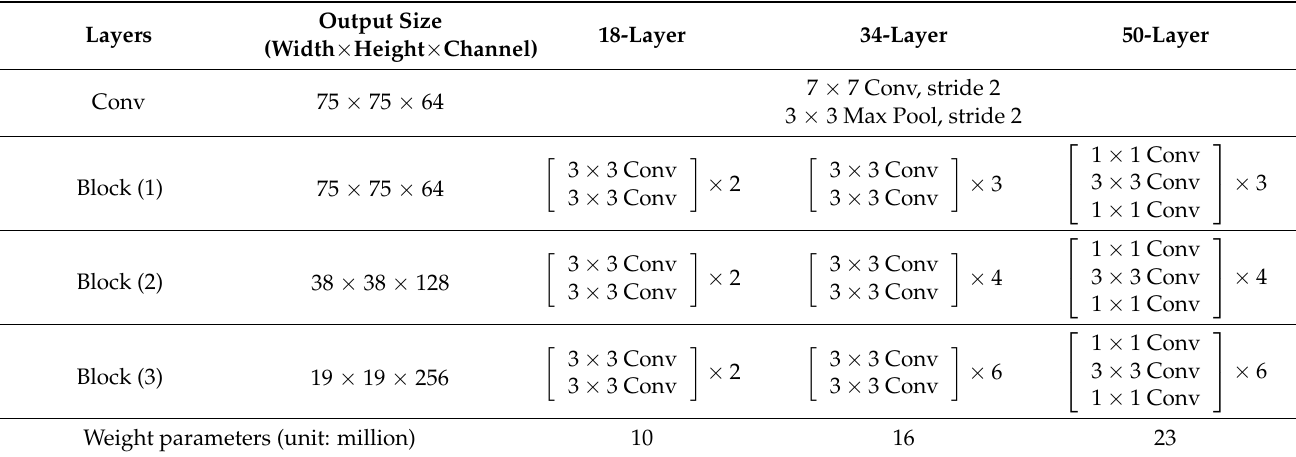
Table 4. Model specification of ResNet based on SSD